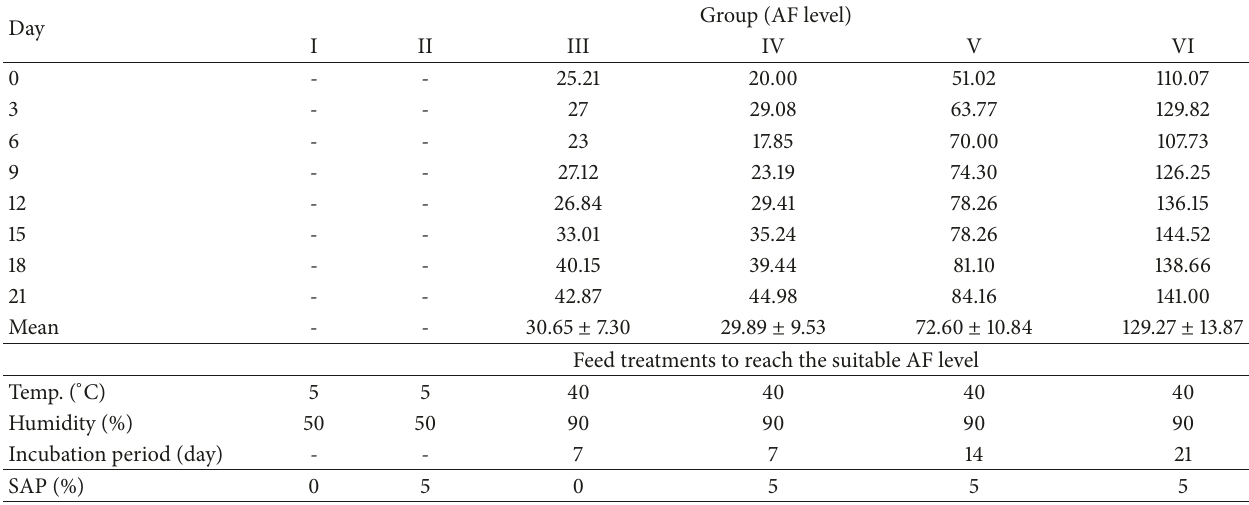
Table 2: AF level in the chicken’s feed from days 0 to 21 (ppb) during the